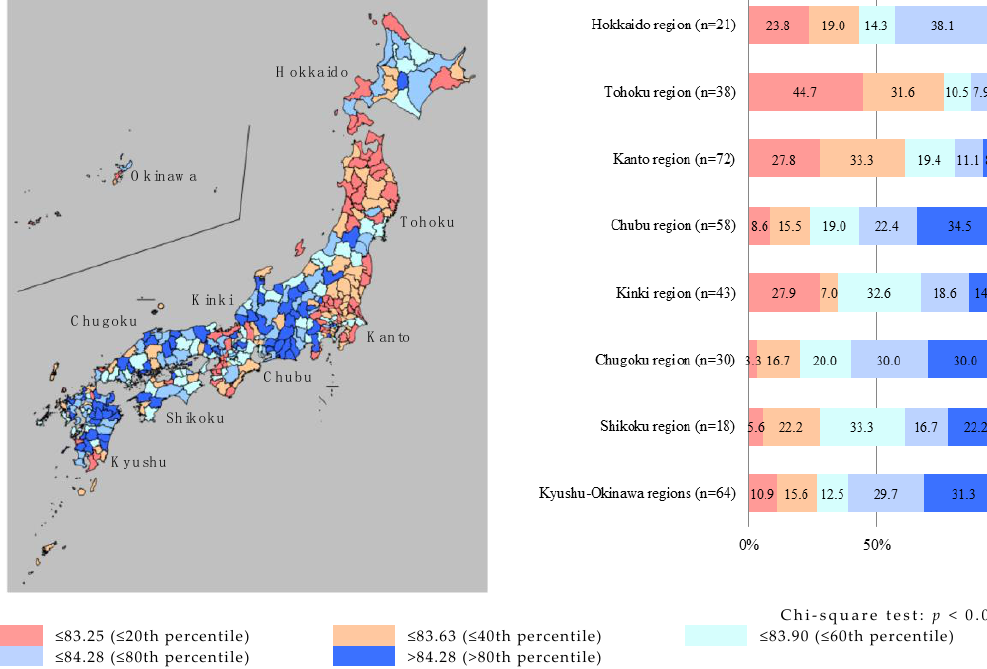
Figure 2. Distribution of healthy life expectancy for females in each secondary medical area. Note: Healthy life expectancy was divided into five categories, by 20th percentiles; The “n” means the number of secondary medical areas in eight regions (Hokkaido, Tohoku, Kanto, Chubu, Kinki, Chugoku, Shikoku, and Kyushu-Okinawa regions).